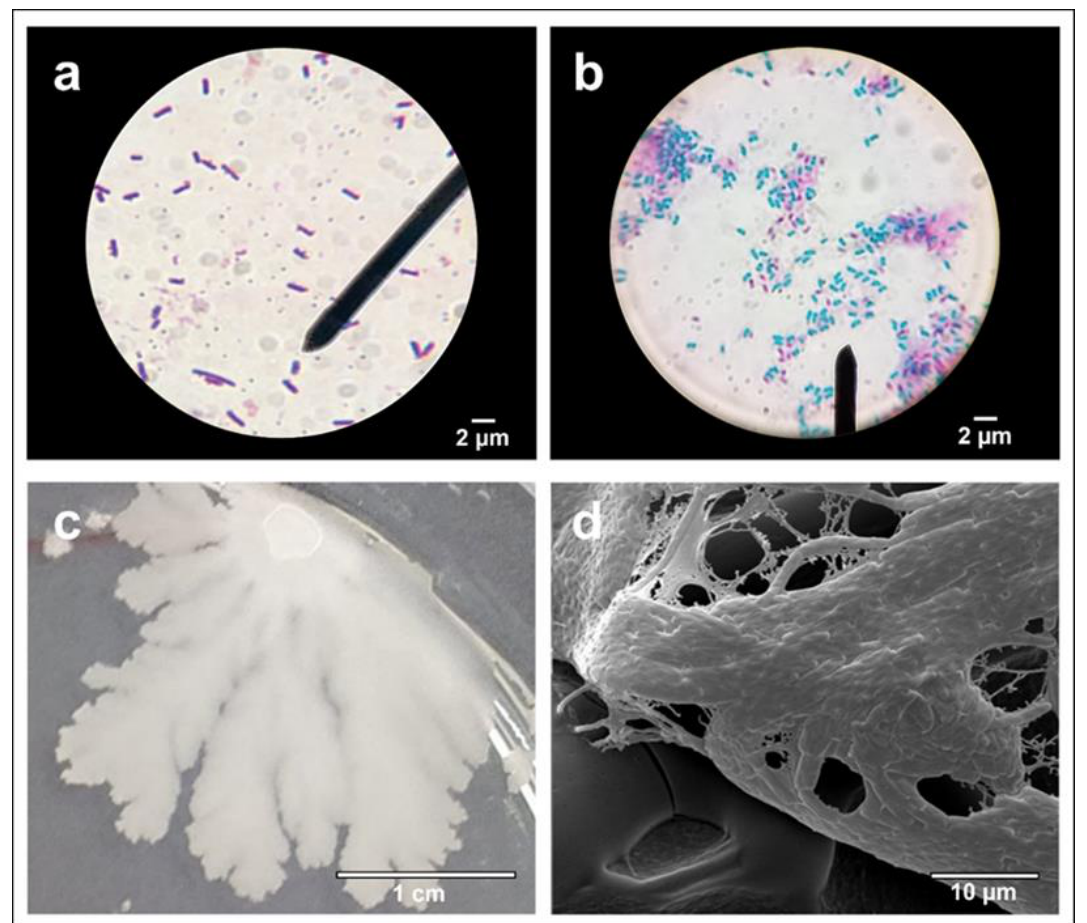
Figure 1. Micrograph of B.BV10 (100× magnification) under an optical microscope after Gram ( a ) and Wirtz – Conklin ( b ) staining; B.BV10 in LBA after 16 h of incubation ( c ); micrograph of B.BV10 (1000× magnification) in SEM ( d ).